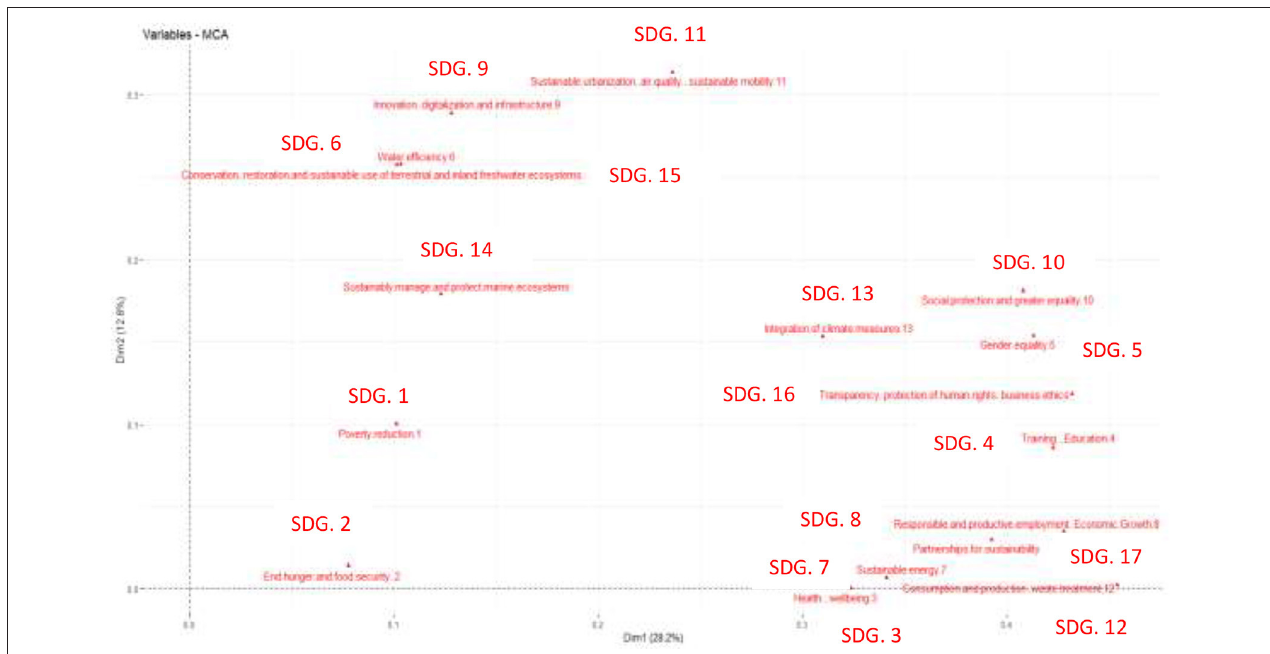
FIGURE 2 | Factor analysis implicit SDG reporting